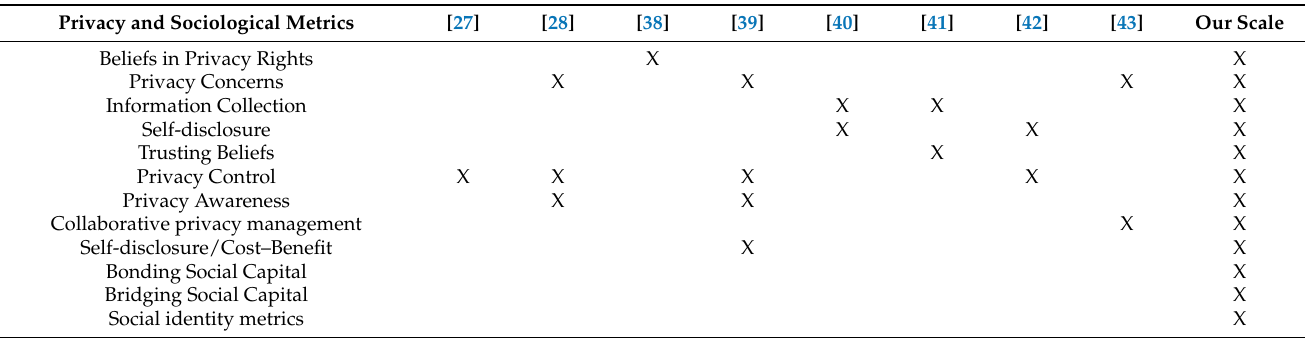
Table 1. Comparison with previous privacy